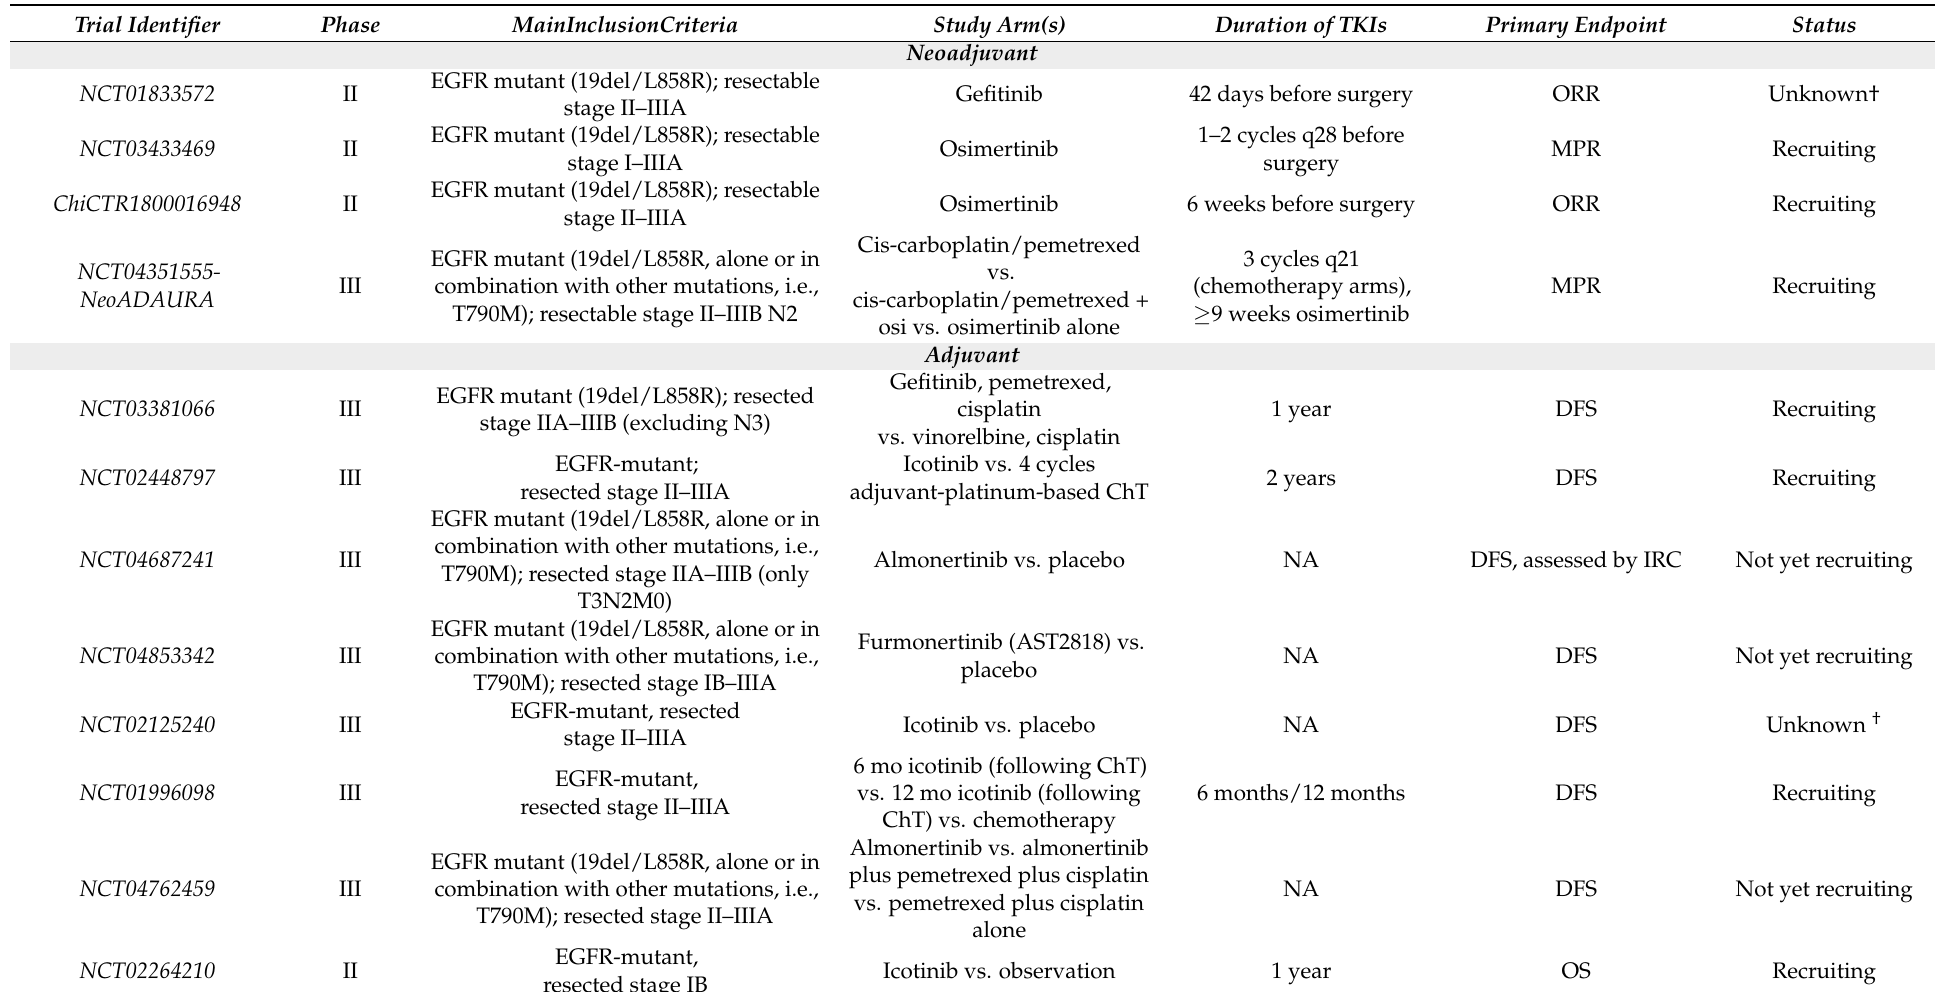
Table 2. Ongoing trials with EGFR TKIs in neoadjuvant and adjuvant